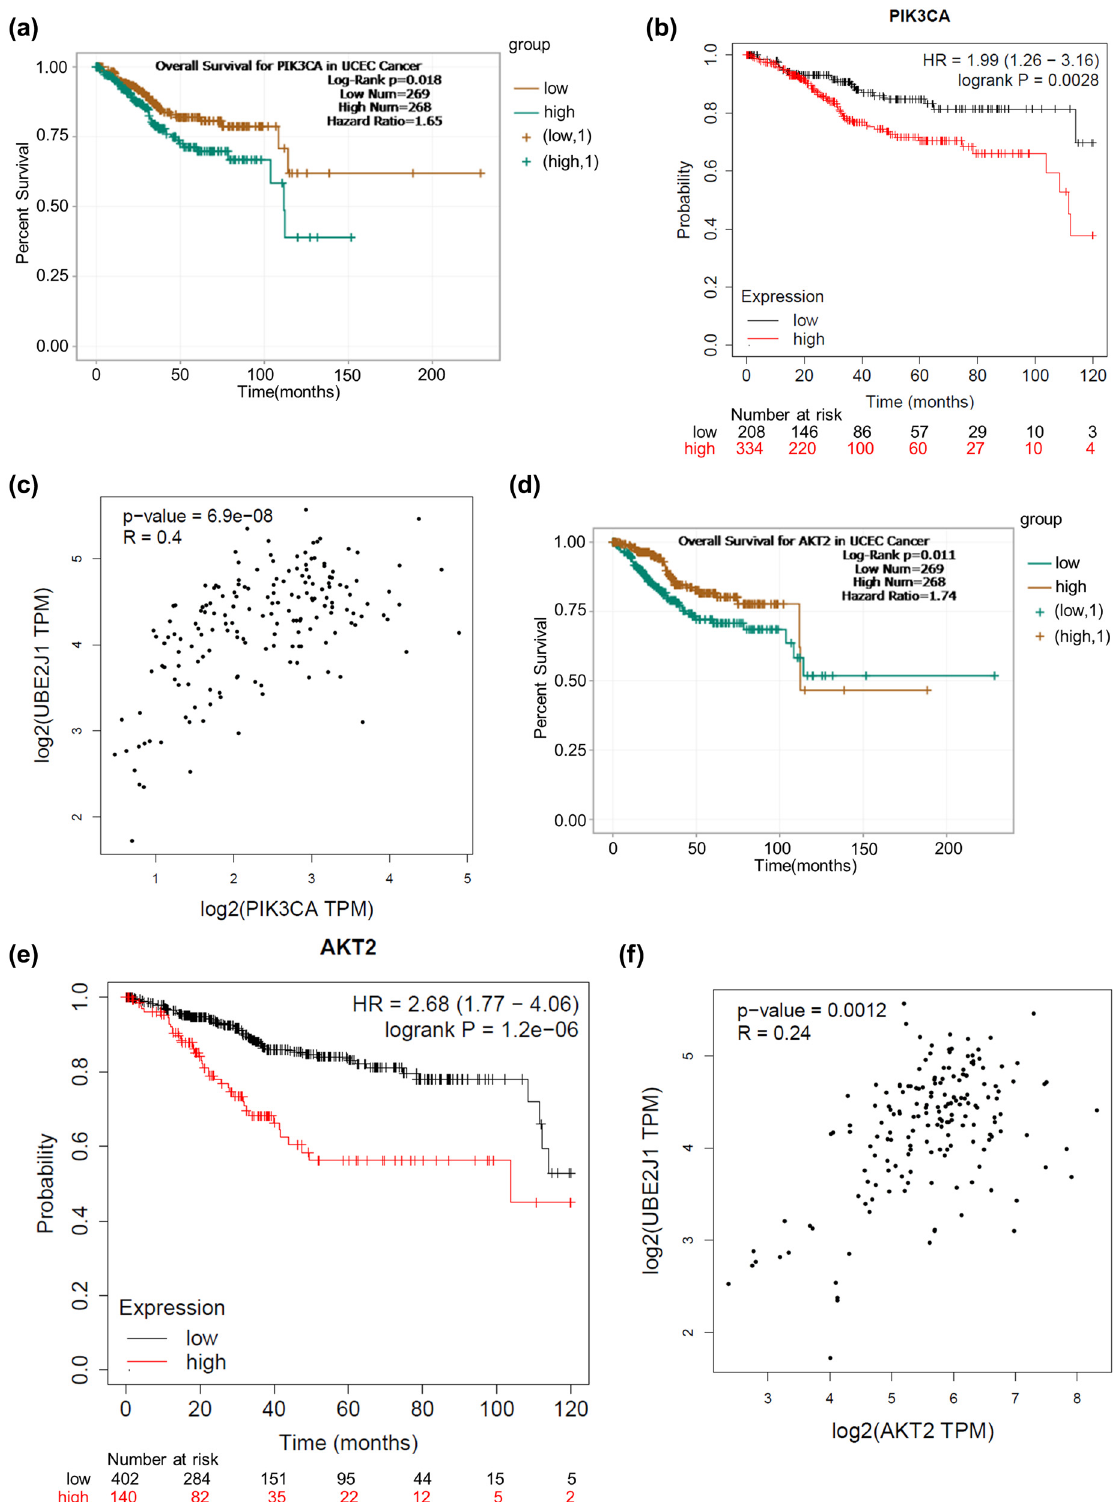
Figure 2: Expression of PI3K and AKT is positively correlated with UBE2J1 expression and is associated with poor prognosis of patients with EC. ( a and b ) ENCORI ( http://starbase.sysu.edu.cn ) and Kaplan – Meier plotter websites ( http://www.kmplot.com/ ) show the overall survival time of UCEC patients with high or low PIK3CA expression. ( c ) GEPIA database ( http://gepia.cancer - pku.cn ) shows the correlation between UBE2J1 expression and PIK3CA expression in UCEC tissues. ( d and e ) ENCORI and Kaplan – Meier plotter websites show the overall survival time of UCEC patients with high or low AKT2 expression. ( f ) GEPIA website shows the relationship between UBE2J1 expression and AKT2 expression in UCEC